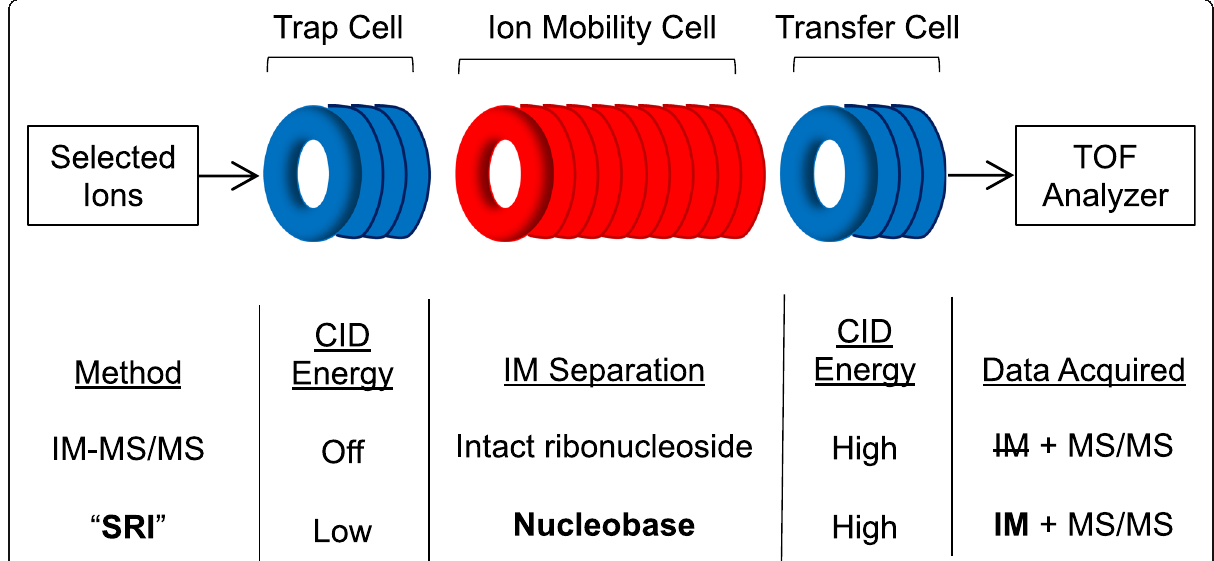
Fig. 1 Schematic diagram of the key components in Waters Synapt G2 that are involved in the ion mobility (IM) measurements and the developed SRI method. Comparison of parameter settings of the key components and outcomes under the standard IM measurements with tandem mass spectrometry and the SRI method are shown. The novelty of the SRI method is highlighted with bolded font. TOF, time-of-flight; CID, collision-induced dissociation; IM, lack of